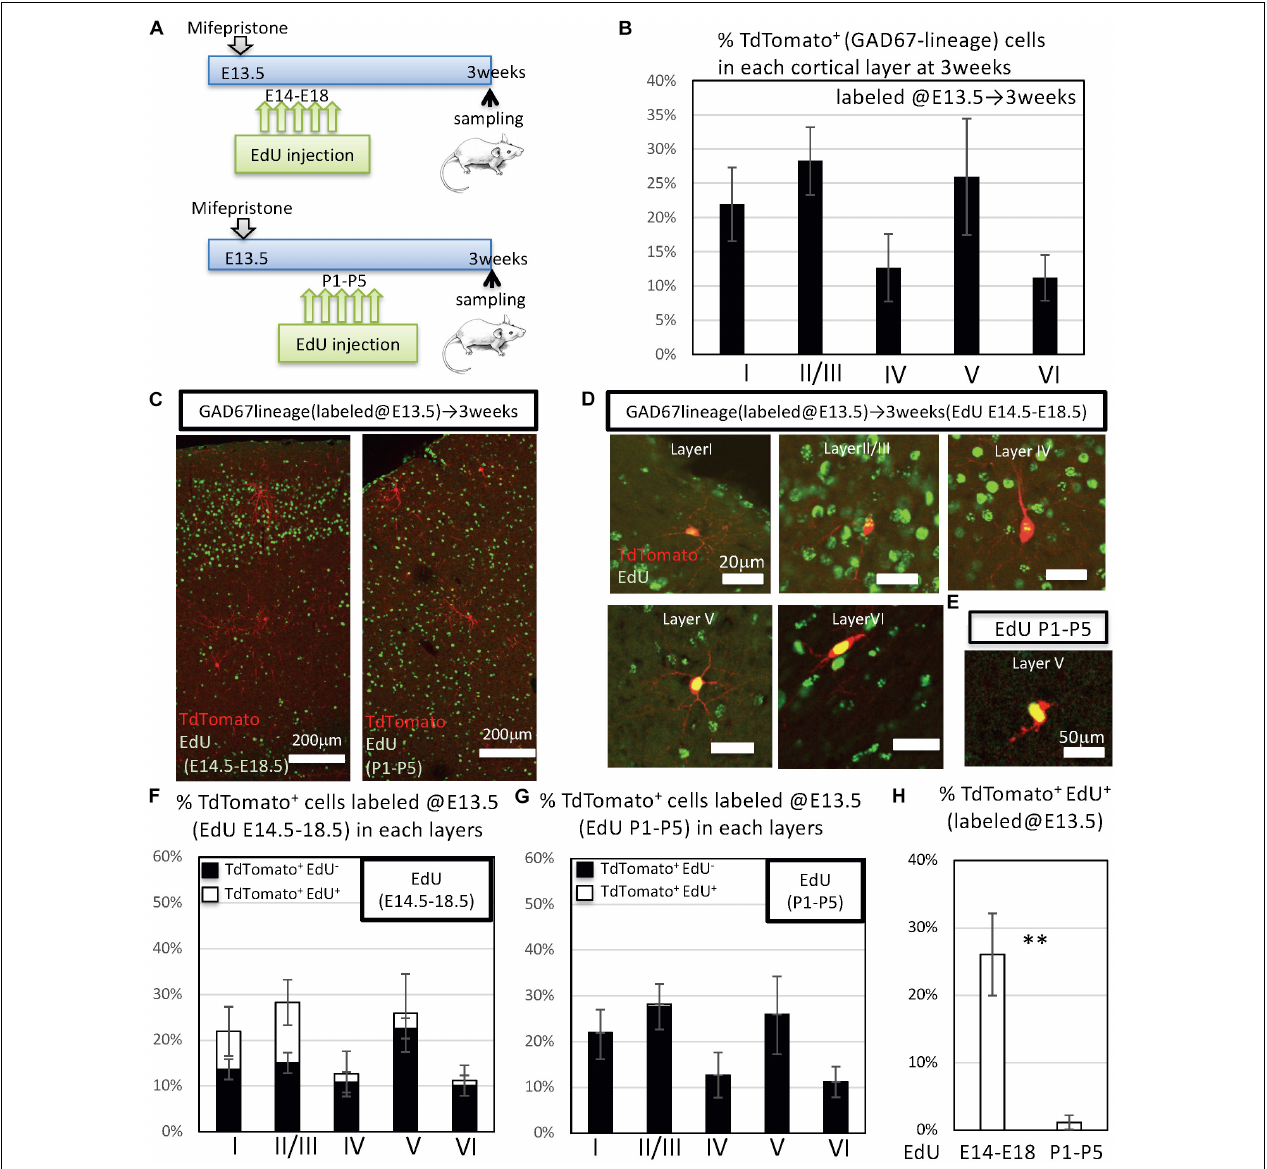
FIGURE 5 | Fate mapping analysis of GAD67 + IPGNs in GAD67-CrePR mice labeled at E13.5. (A) Experimental design for labeling IPGNs at the embryonic stage. Mifepristone was administered to pregnant GAD67-CrePR;Ai9 mice at E13.5, and EdU was injected i.p. from E14.5 to E18.5 or P1 to P5. Mifepristone- and EdU-treated mice were analyzed at 3 weeks. (B) Percentages of TdTomato + GAD67-lineage cells labeled at E13.5 in each cortical layer. Error bars represent SDs ( n = 9 brains). (C) Coronal section of GAD67-CrePR;Ai9 mouse labeled at E13.5 at 3 weeks with EdU staining (green). EdU was injected E14.5–E18.5 (left) P1–P5 (right) by dual-fluorescence immunohistochemistry. (D) Representative images of TdTomato + GAD67-lineage cells labeled at E13.5 with EdU (E14–18) (green) in each cortical layer at 3 weeks. (E) Representative image of TdTomato + GAD67-lineage cells with EdU (P1–P5) (green) in cortical layer V at 3 weeks. (F) Percentages of TdTomato + cells labeled at E13.5 with EdU (E14–E18) in each cortical layer. Error bars represent SDs ( n = 6 brains). (G) Percentages of TdTomato + cells labeled at E13.5 with EdU (P1–P5) in each cortical layer. Error bars represent SDs ( n = 6 brains). (H) Percentages of TdTomato + EdU + GAD67-lineage cells labeled at